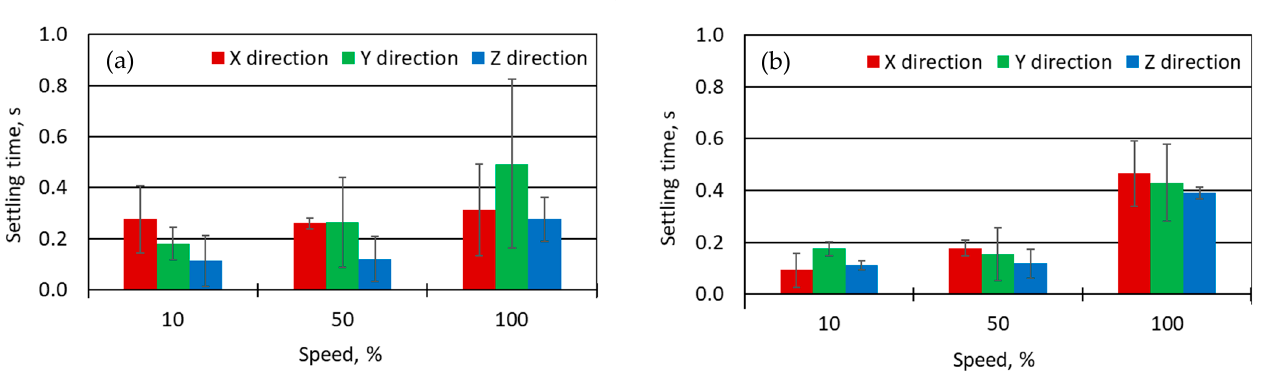
14 of 21 Figure 10. Peak-to-peak vibrations amplitudes: ( a ) at the start (measuring) position (Figure 3a), ( b ) at the endpoint of the trajectory (Figure 3b). Statistical evaluation was performed according to Equations (8)–(13). From Figure 10a, it is seen that the average amplitude of the vibrations increases when the speed of the robot increases practically on all measured axes. The highest values of vibration levels were recorded at the highest speed. Comparing vibration levels in separate axes, we noticed that the highest values (0.75 g at speed 10% and 1.6 g at speed 100%) were defined on the y -axis. Results presented in Figure 10b show the following inverse tendency: here, the highest values of vibration level occur when the robot moves at 10% speed. By analyzing